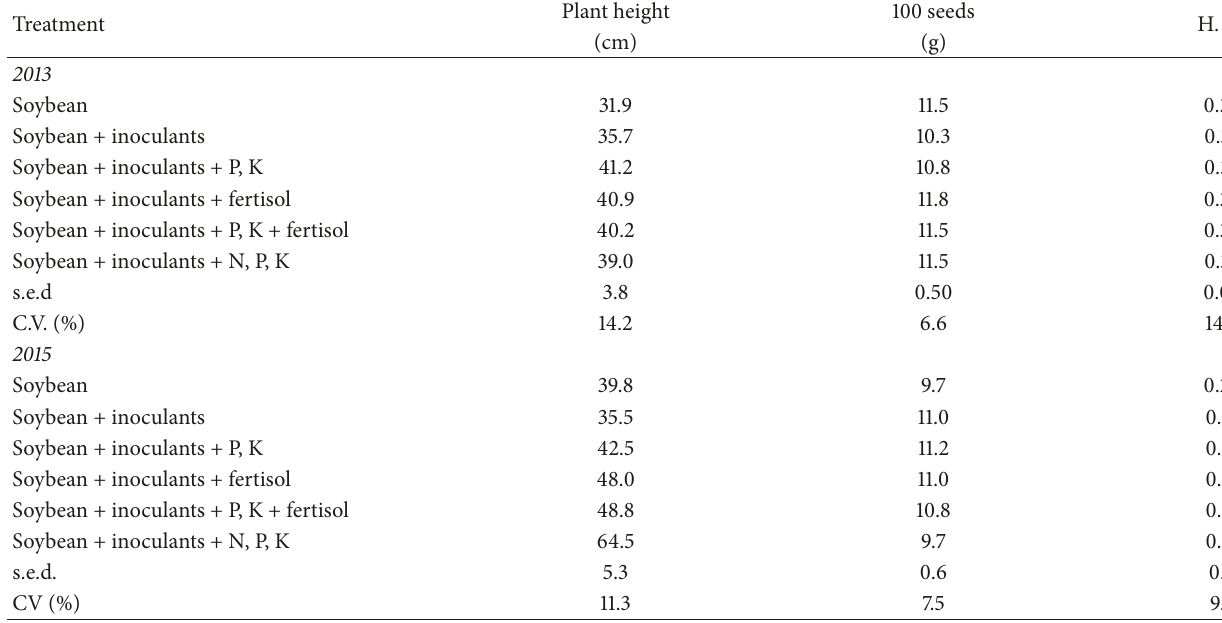
Table 2: Soybean growth and development as affected by inoculation and soil amendments in the northern savanna of Ghana.